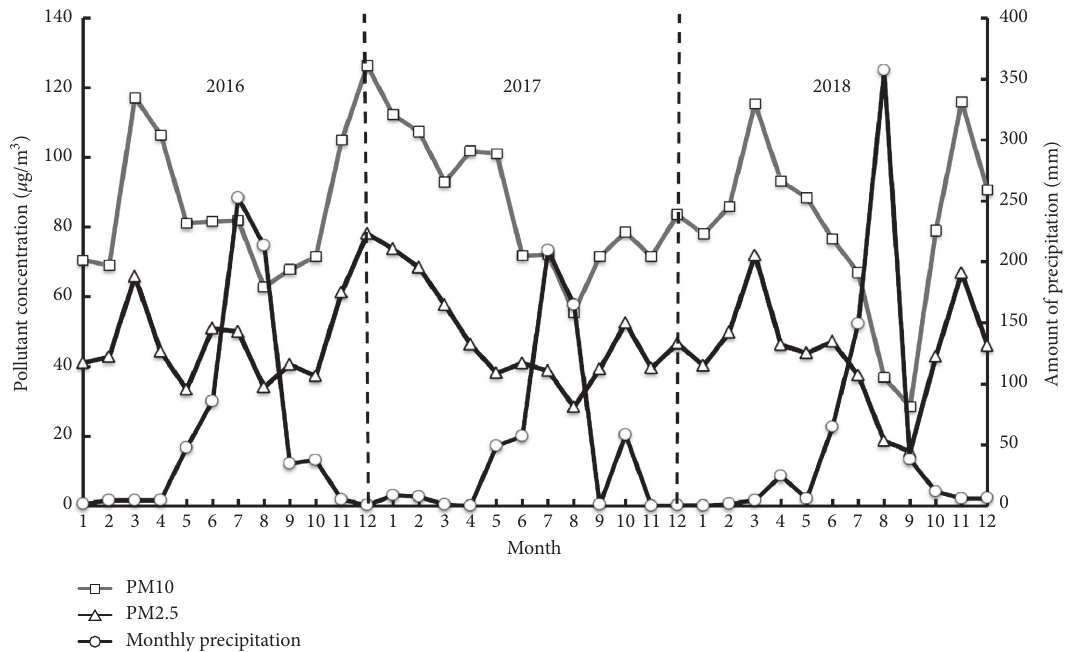
Figure 2: Monthly rainfall, PM2.5 and PM10 concentrations in Qinhuangdao from 2016 to